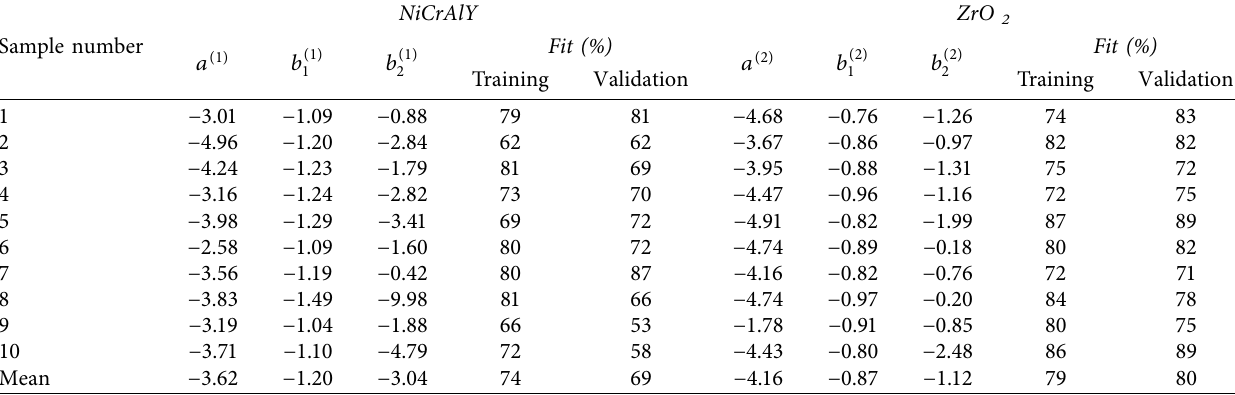
Table 7: Estimated parameters in equation (3) of the averaged z –locations of the NiCrAlY and the ZrO Tables 5 and